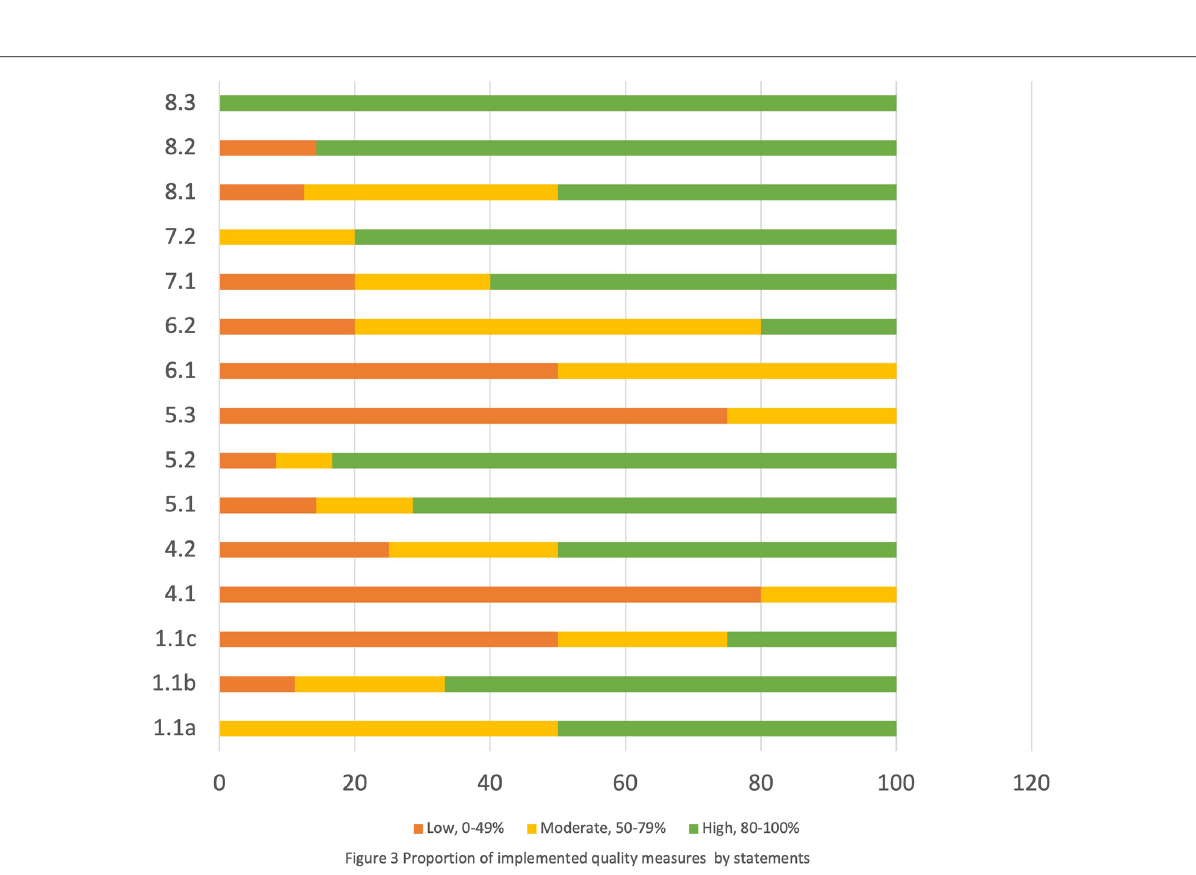
FIGURE 3 Proportion of implemented quality measures by